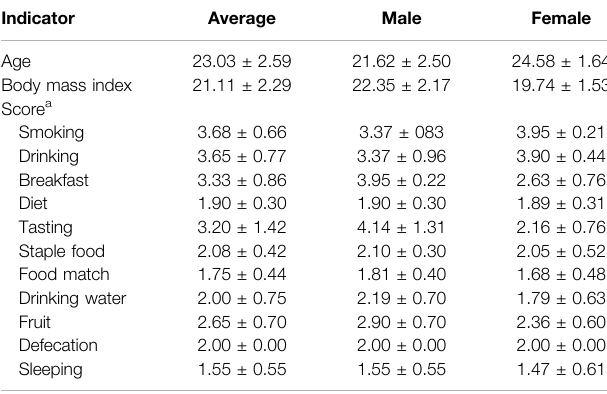
TABLE1| Basicinformationanddiethabitsofparticipants.Datawerereportedas mean ± SEM.